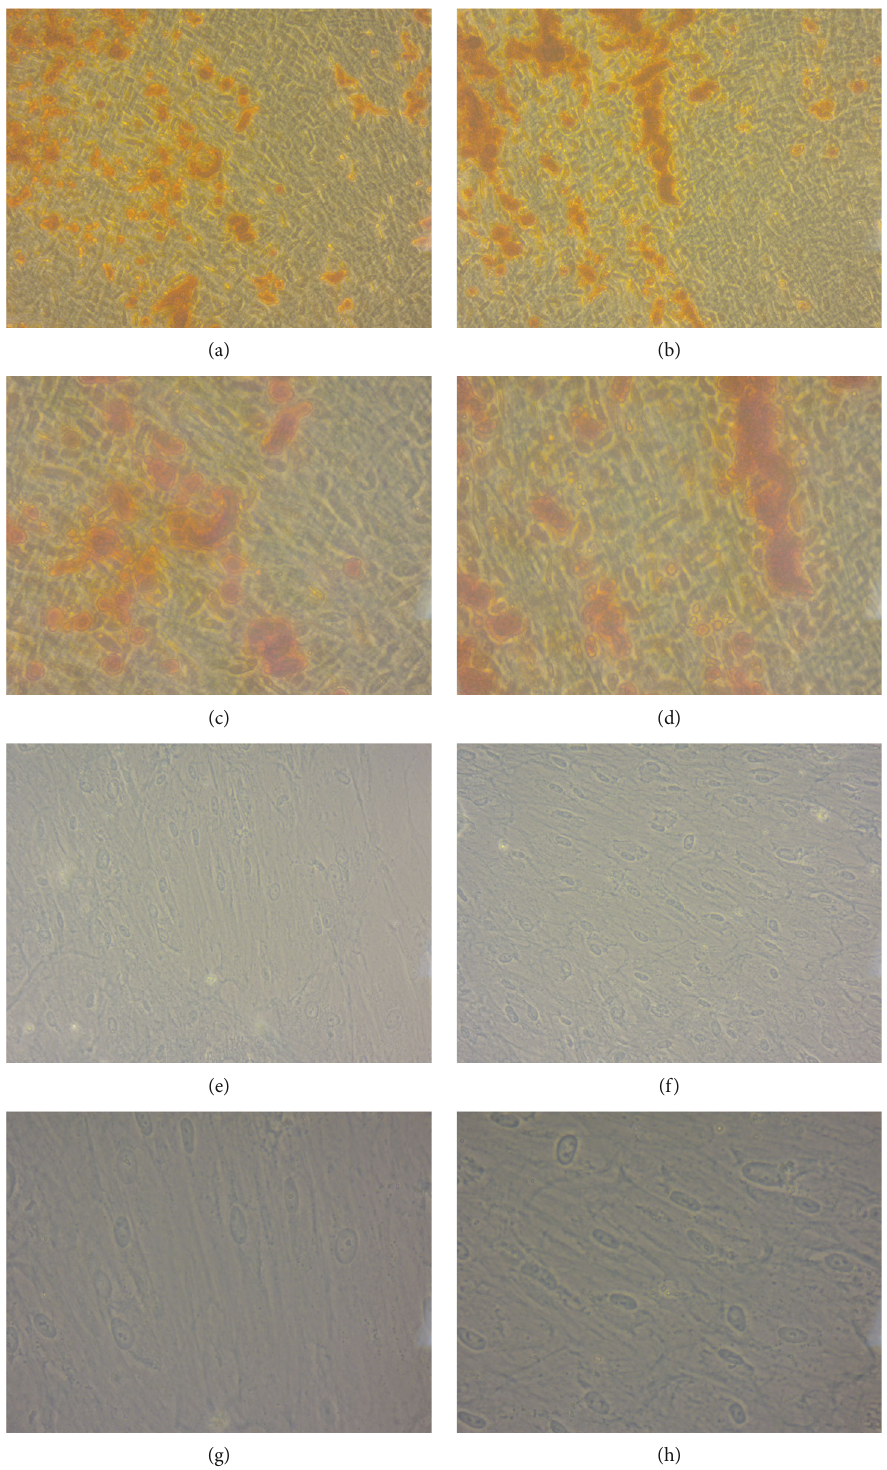
Figure 4: Osteogenic di ff erentiation: (a) 200x control group, (b) 200x test group, (c) 400x control group, and (d) 400x test group. Chondrogenic di ff erentiation: (e) 200x control group, (f) 200x test group, (g) 400x control group, and (h) 400x test